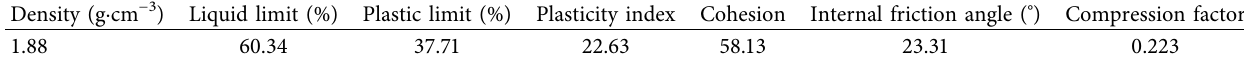
Table 1: Physical and mechanical properties of clay samples.